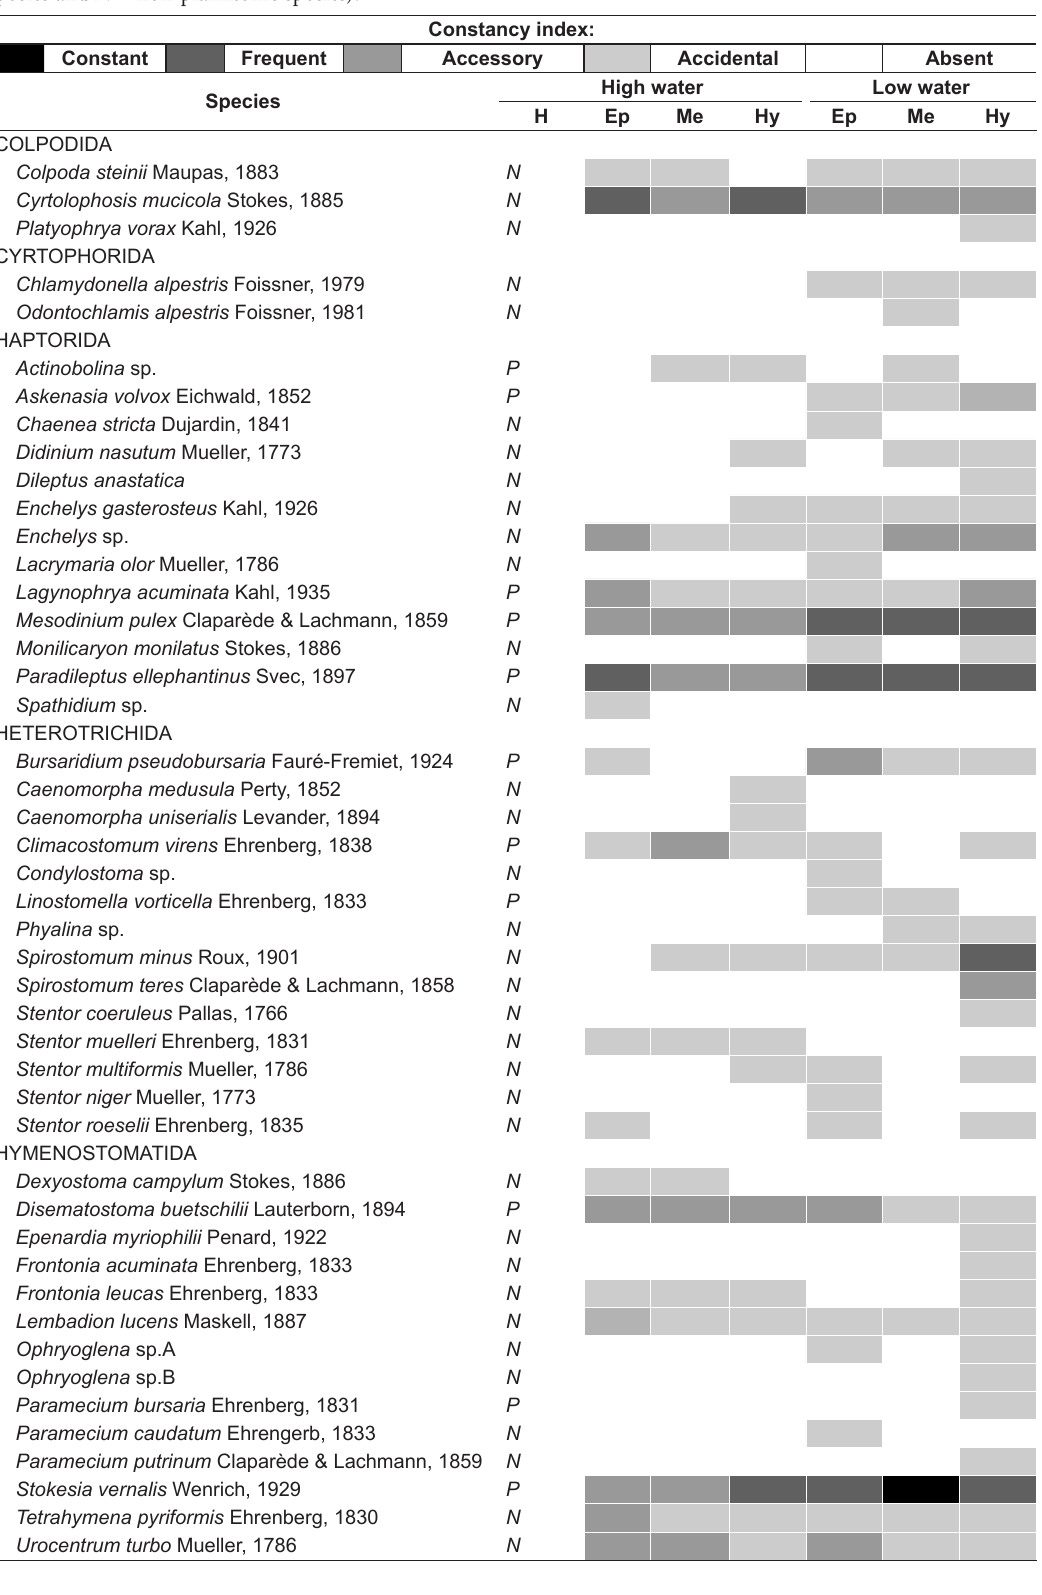
Table 1. List of ciliate species registered in distinct strata (Ep = Epilimnion; Me = Metalimnion; Hy = Hypolimnion) in two hydrological periods (High water and Low water) at Guaraná Lake (H = Preferential Habitat; P = planktonic species and N = non-planktonic